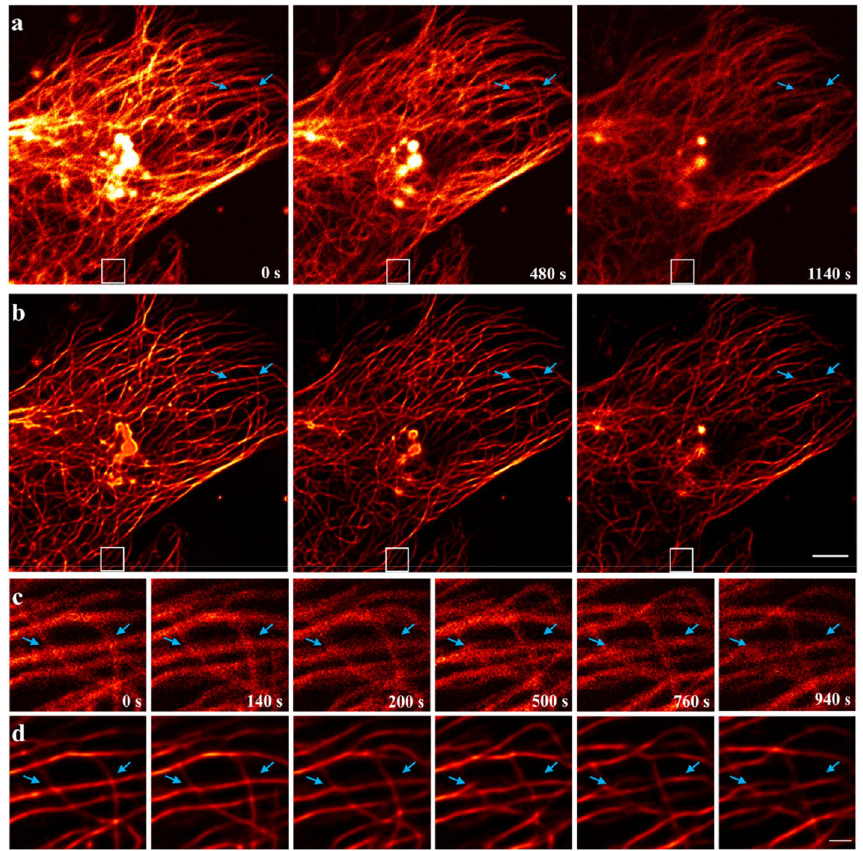
Fig. 9 Super-resolution imaging of live-cell microtubules captured with the Nikon A1R MP Time-lapse confocal images at three time points used as input to the network. ( b ) Time-lapse network output images at three time points. Scale bar, 4 μm. ( c ) Time-lapse confocal images at six time points are shown at a magnified scale. ( d ) Time-lapse network output images at six time points are shown at a magnified scale. Scale bar, 1